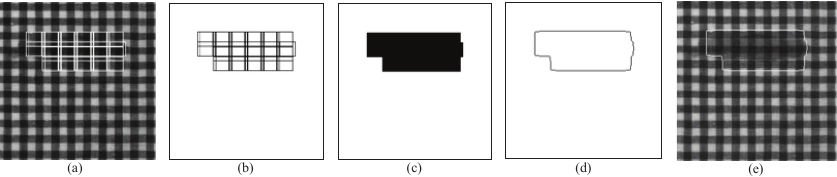
Figure 13. Illustration of defect fusion for the method based on universal quality index: (a) Boundaries of the defective blocks identified from each cropped image shown superimposed on the original defective image; (b) Boundaries of the defective blocks shown separately on plain background; (c) Result of morphological filling; (d) Canny edge detection; (e) Identified edges shown superimposed on the original defective image using white